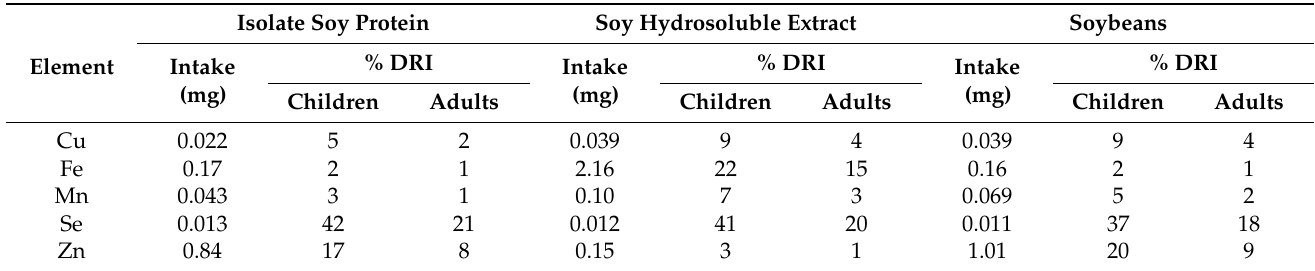
Table 6. Cu, Fe, Mn, Se and Zn contribution to daily intake through consumption of one glass of soy-based beverages (200